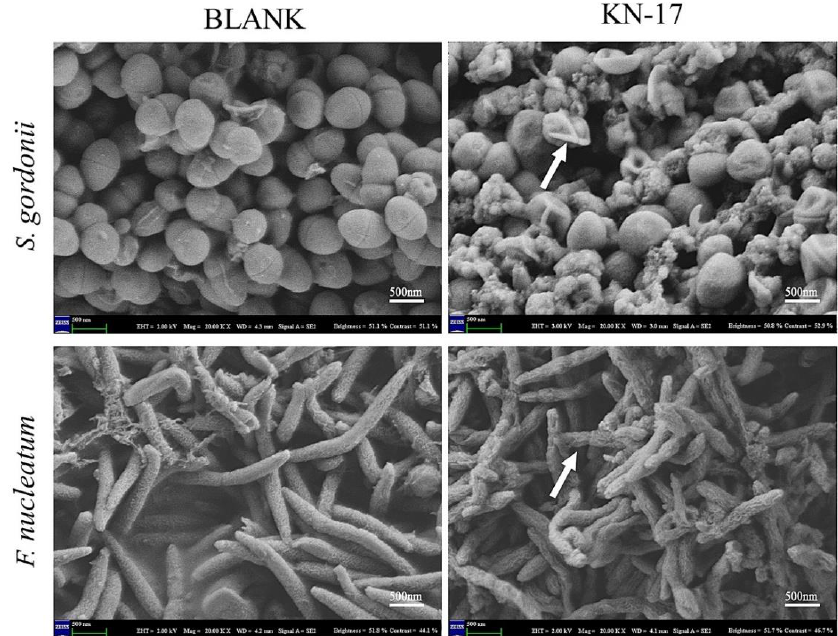
Figure 4. SEM images of S. gordonii and F. nucleatum biofilms treated with KN-17, respectively. The changes in bacterial morphology were observed under SEM. As indicated by the white arrows, significant cell wall distortion, corrugation, and damage were observed on the surface of S. gordonii and F. nucleatum cells after treatment with the peptide compared with the smooth surface of the control.